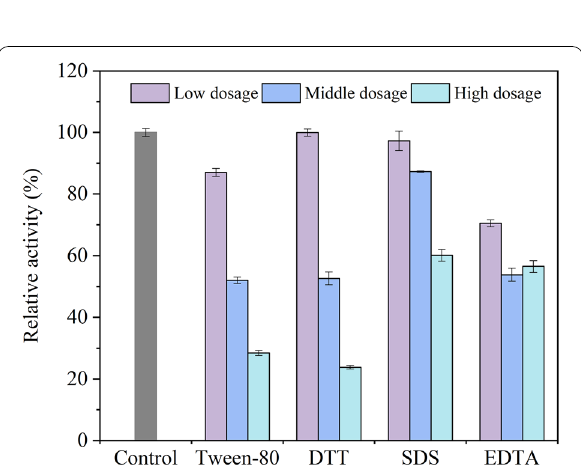
Fig. 7 Effect of putative inhibitors on CGLac activity(Tween-80 concentrations were 1.0%, 5.0% and 10.0%, respectively; DTTconcentrations were 0.1, 0.5, 1.0 mM, respectively; SDS concentrations were1.0, 5.0, 10.0 mM, respectively; EDTA concentrations were 1.0, 5.0, 10.0 mM